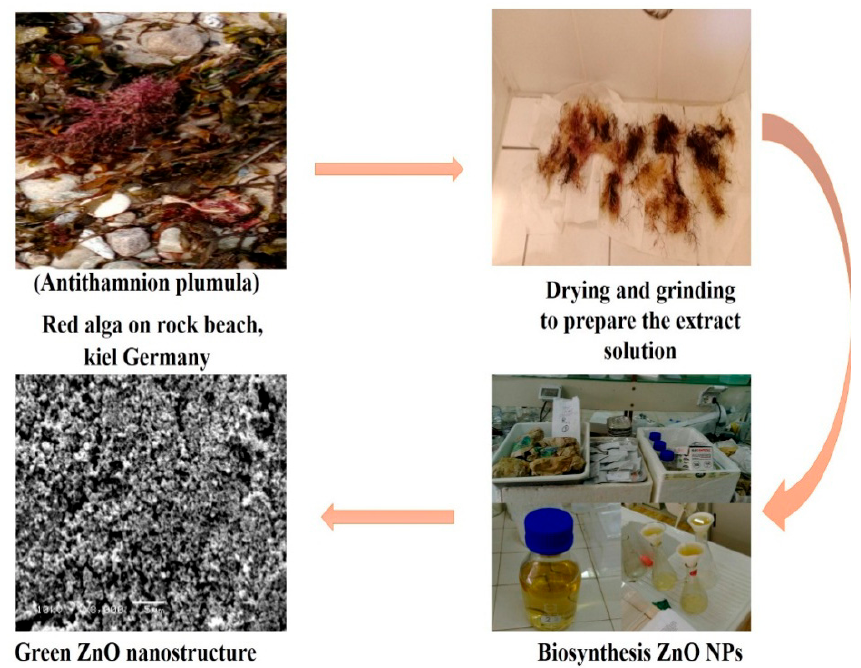
Figure 2. Phycosynthesis route of ZnO nanoparticles (NPs) from A. plumula extracts.